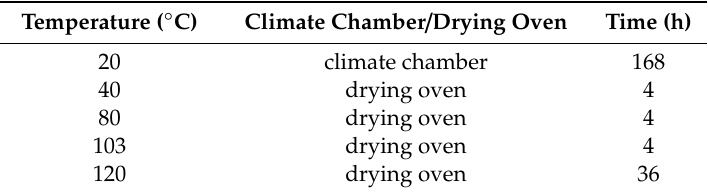
Table 2. Drying scheme for